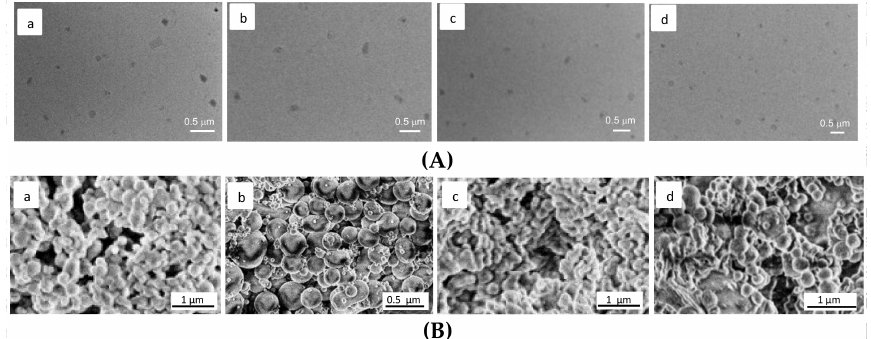
Figure 9. ( A ) (a–d of the top panel) scanning electron micrograph of TSPO-Dex NGs 7 (a); TSPO-Dex NGs 8 (b); TSPO-Dex NGs 10 (c) and TSPO-Dex NGs 11 (d). ( B ) (a–d of the bottom panel) transmission electron micrograph of TSPO-Dex NGs 7 (a); TSPO-Dex NGs 8 (b); TSPO-Dex NGs 10 (c) and TSPO-Dex NGs 11